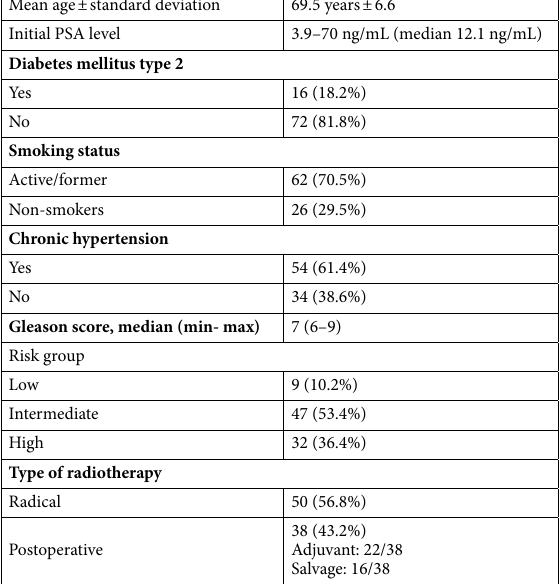
Table 1. Patient’s, clinical and treatment characteristics. PSA- prostate specific